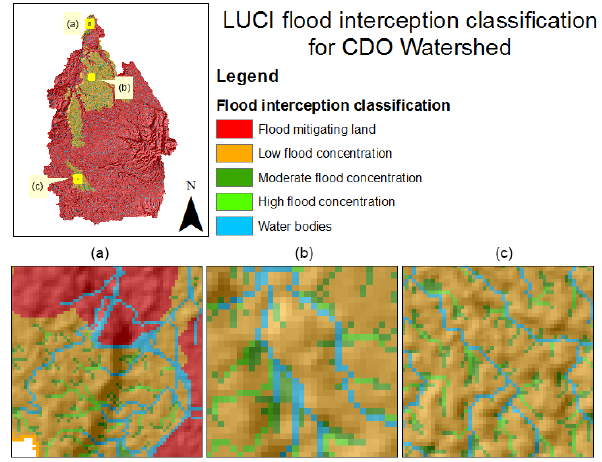
Figure 4. A zoom of some areas of the watershed to show flood interception at a smaller